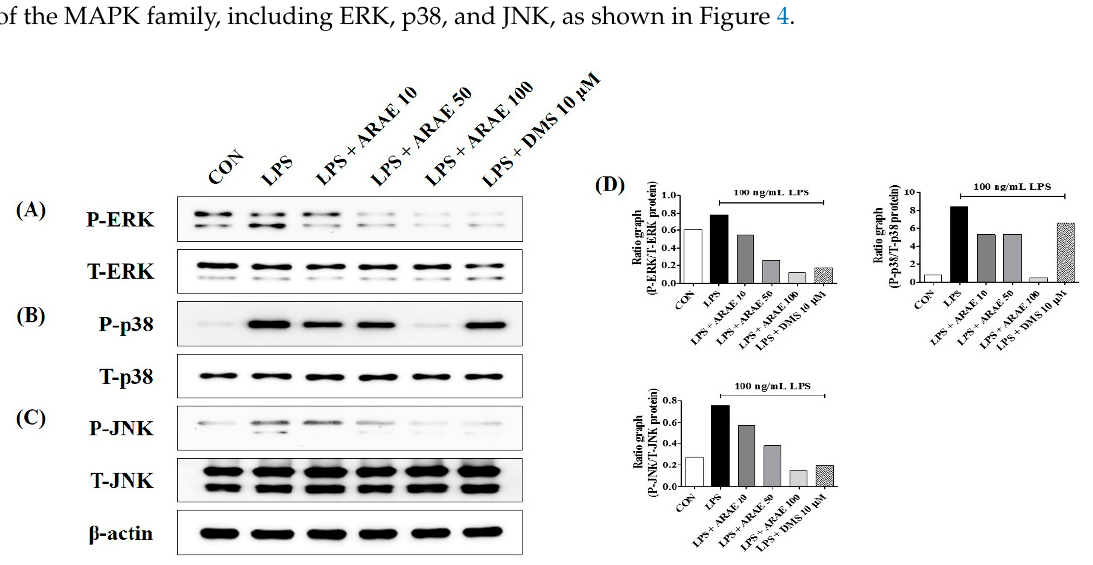
Figure 4. Effects of ARAE on phosphorylation of ( A ) extracellular signal-regulated kinase (ERK), ( B ) p38, and ( C ) c-Jun NH 2 -terminal kinase (JNK) mitogen-activated protein kinases (MAPK). Cells were seeded on a culture plate and pre-incubated for 18 h. Control cells were incubated with vehicle alone. Cells were stimulated with LPS for 30 min. ( D ) The histograms show protein expression levels relative to those of total-type protein. CON: control; LPS: lipopolysaccharide; ARAE: Atractylodis Rhizoma Alba ethanolic extract; DMS: dexamethasone.